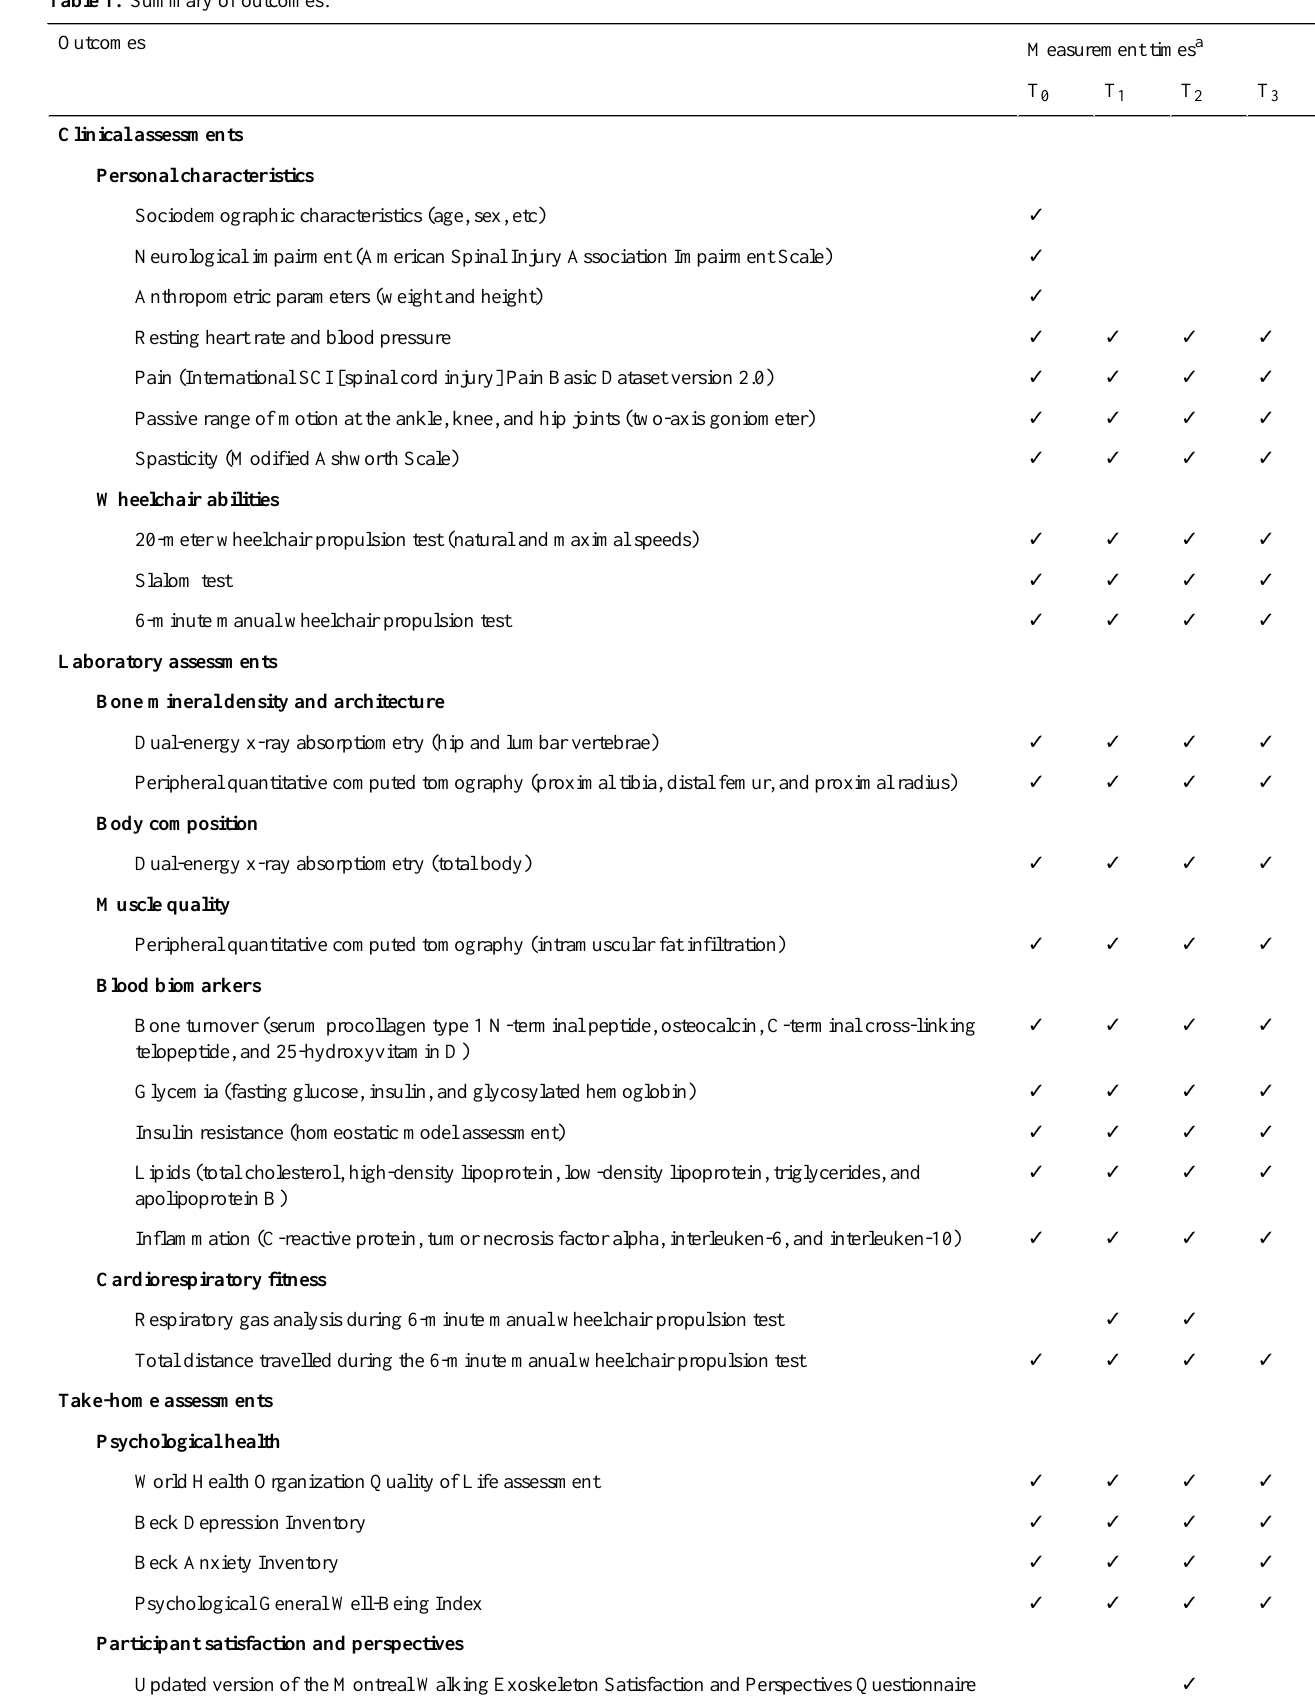
Table 1. Summary of